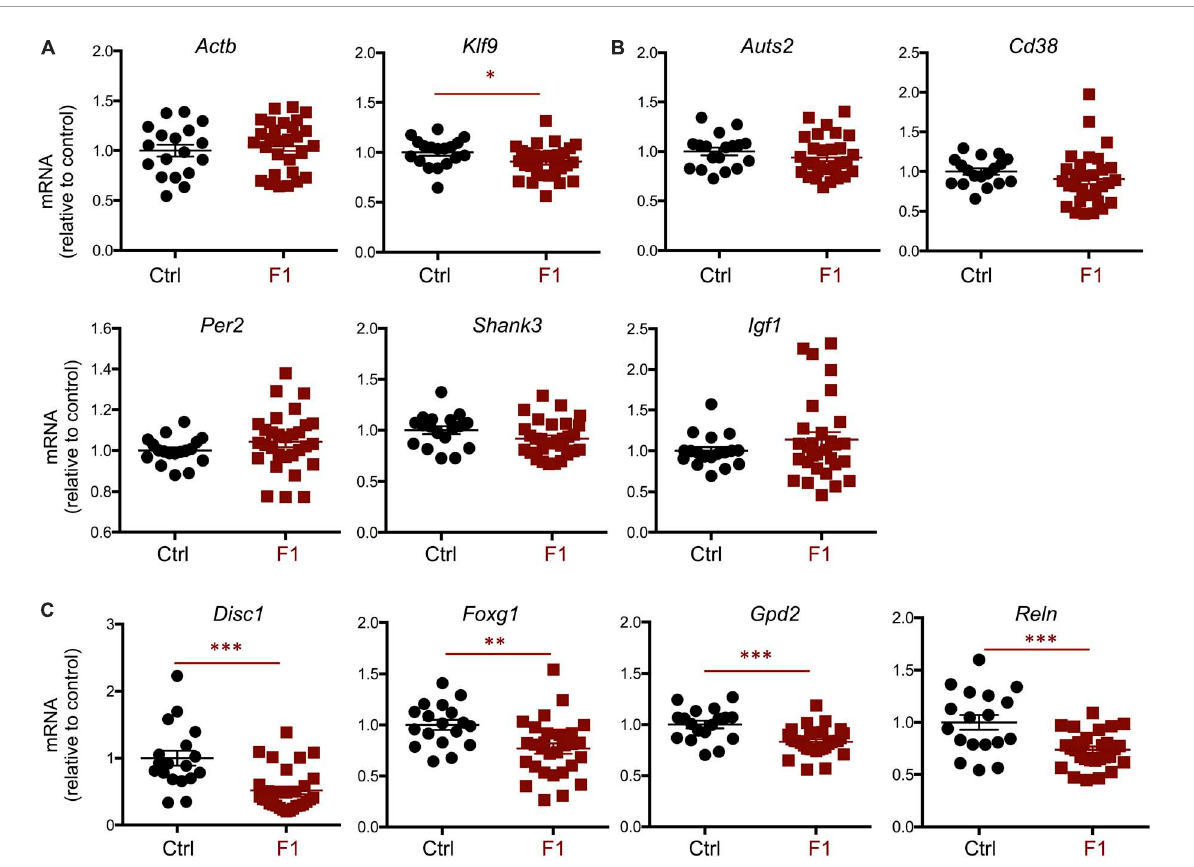
FIGURE9 Gene expression in F1 generation E13.5 brains. (A) Expression of house-keeping gene Gapdh and thyroid hormone-responsive Klf9 . (B) Genes showing no significant difference in expression. (C) Genes showing a significant decrease in expression. Each point represents a different embryo ( n = 18, 29) and mean ± SEM are shown. Experimental embryos represent 3–4 different litters. ∗ , ∗∗ , and ∗∗∗ indicate P < 0.05, 0.01, and 0.001, respectively, as determined by the Student’s t